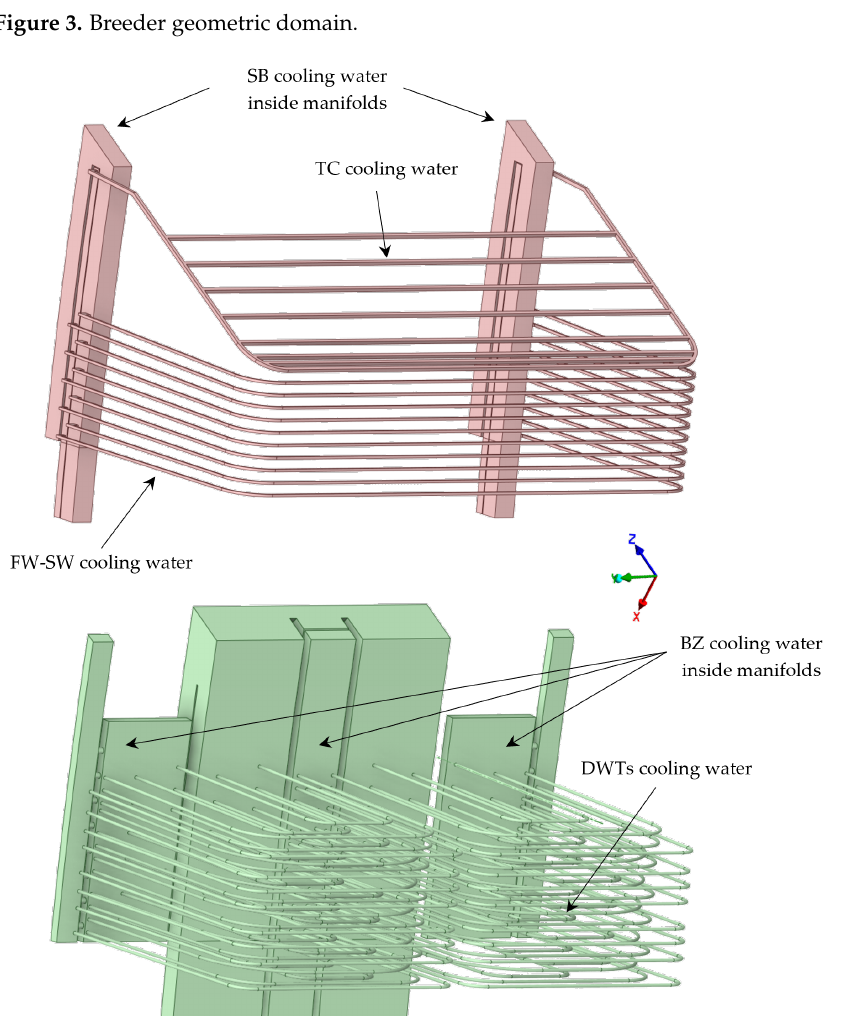
Figure 4. Water geometric domains: SB ( top ) and BZ ( bottom ) cooling